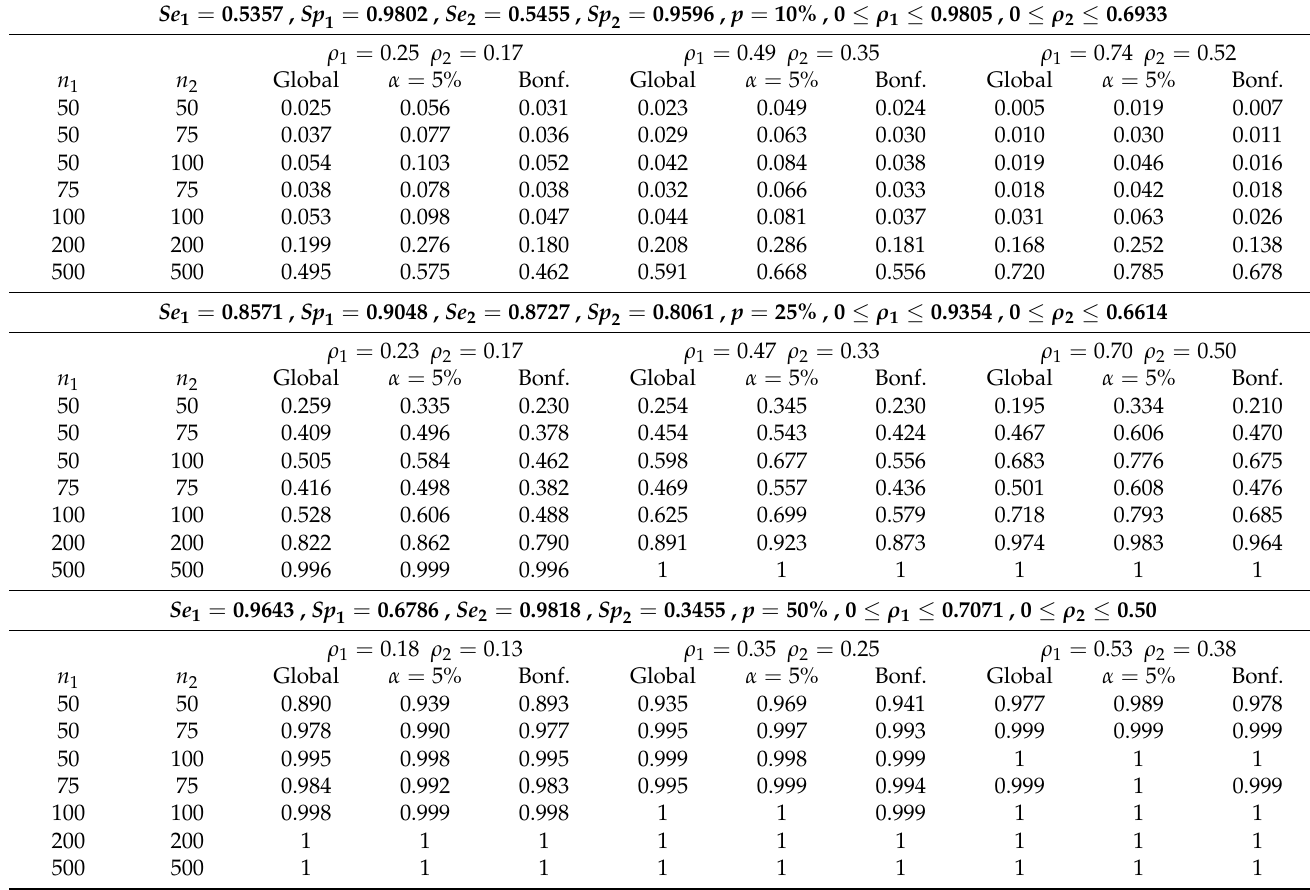
Table 4. Powers for PPV 1 = 0.75, NPV 1 = 0.95, PPV 2 = 0.60 and NPV 2 =